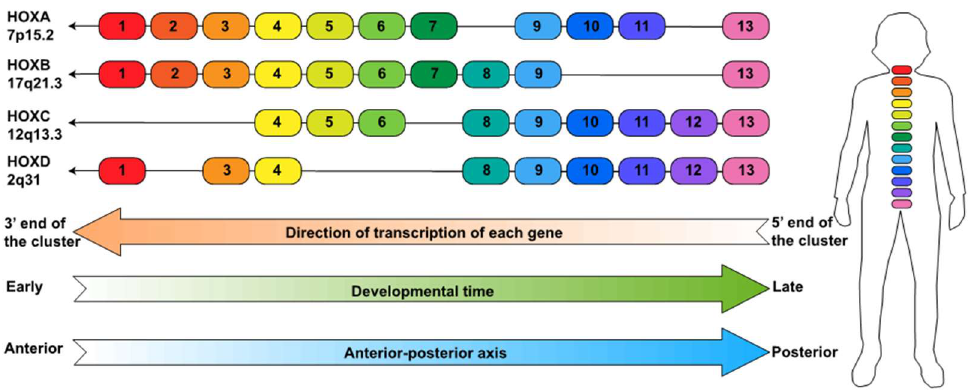
Figure 1. The HOX loci. Shown are the HOX family members present in each of the four loci, along with the direction of individual gene transcription and the directions of the spatial and temporal waves of transcription of the genes in each cluster; shown on the right is a schematic indicating the relative positions in the human body at which the HOX paralogs are expressed during development.